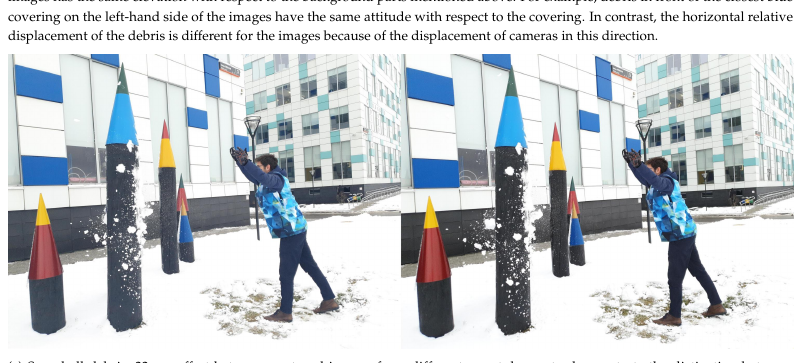
Figure 14. Three pairs of photos, the first two of which were synchronously shot by two smartphones. Synchronization is done by our app [6]. The third pair was shot without synchronization for comparison